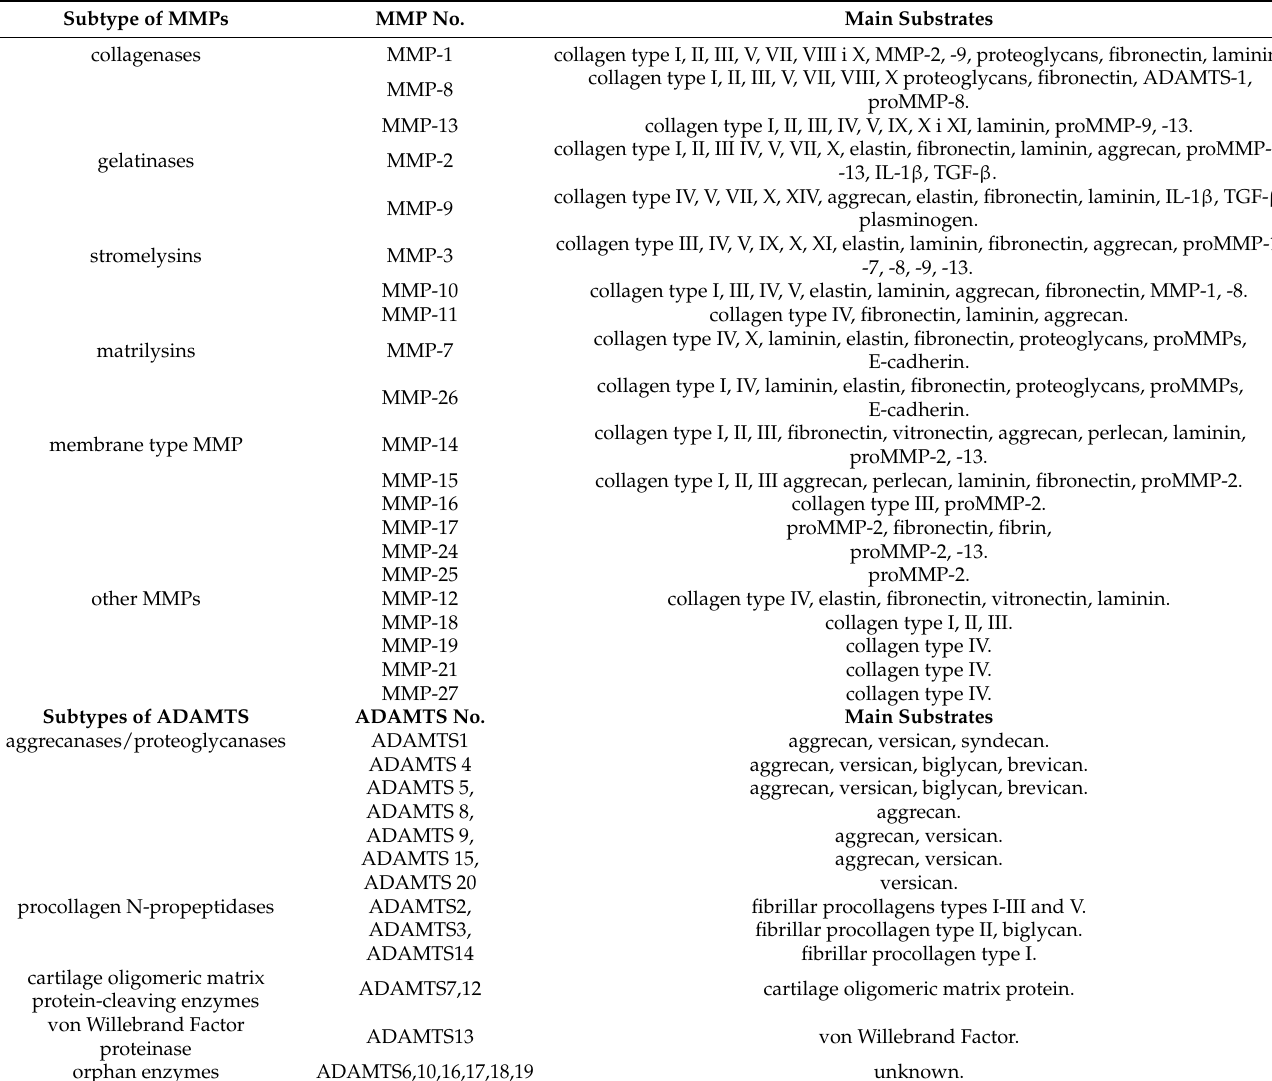
Table 1. Subtypes of MMPs and ADAMTS and their main substrates